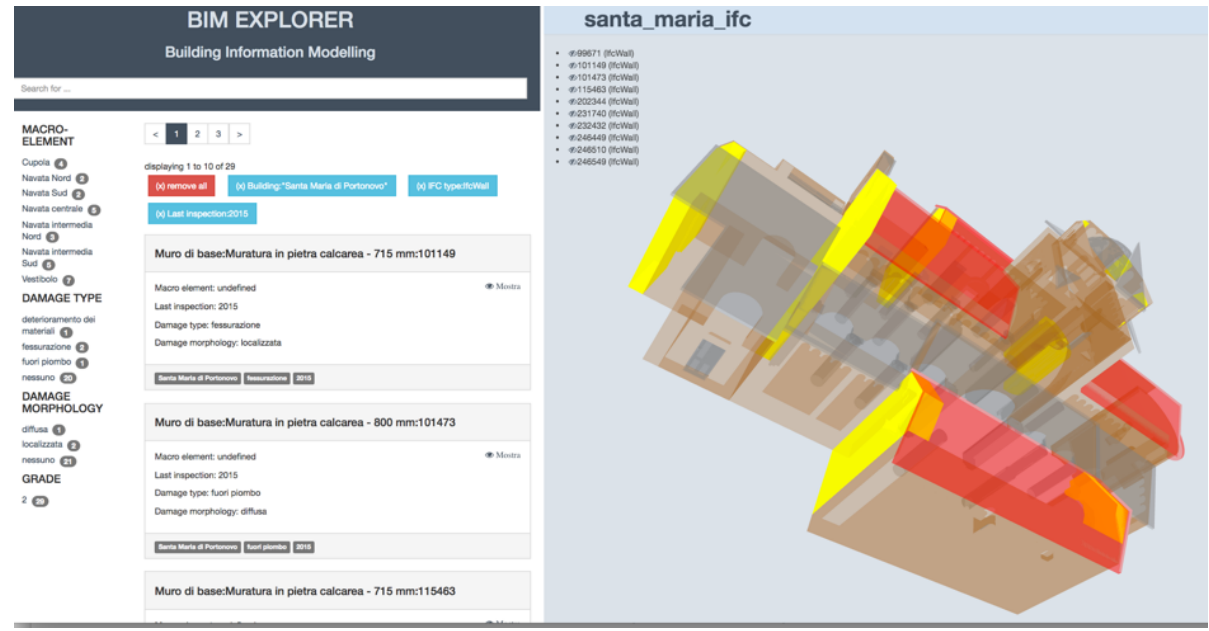
Figure 10. the visualization in 3D of the elements that have been searched through the faceted